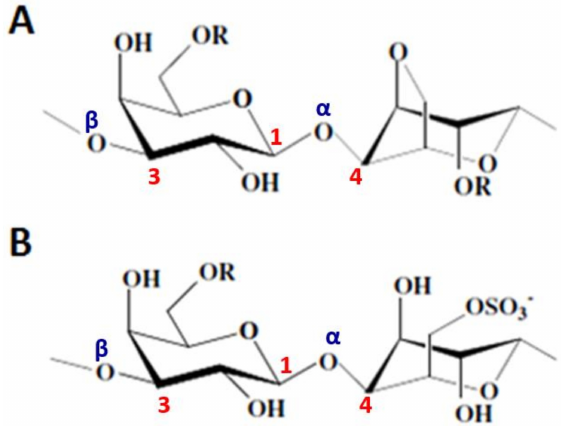
Figure 10. Structures of ( A ) porphyrans and ( B ) funorans. R: CH 3 or SO 3 −